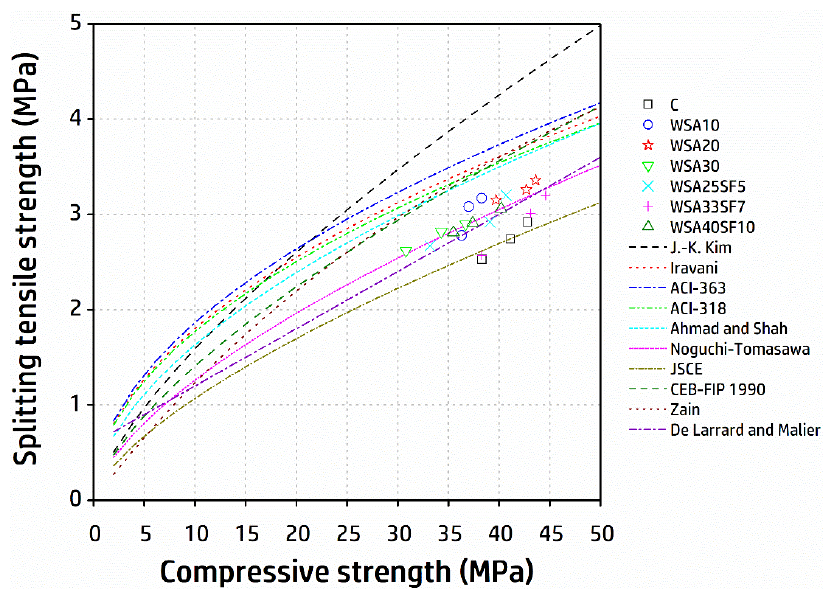
Figure 5. Comparison of the correlation between experimental compressive and tensile strengths for different concrete mixtures with existing prediction models.